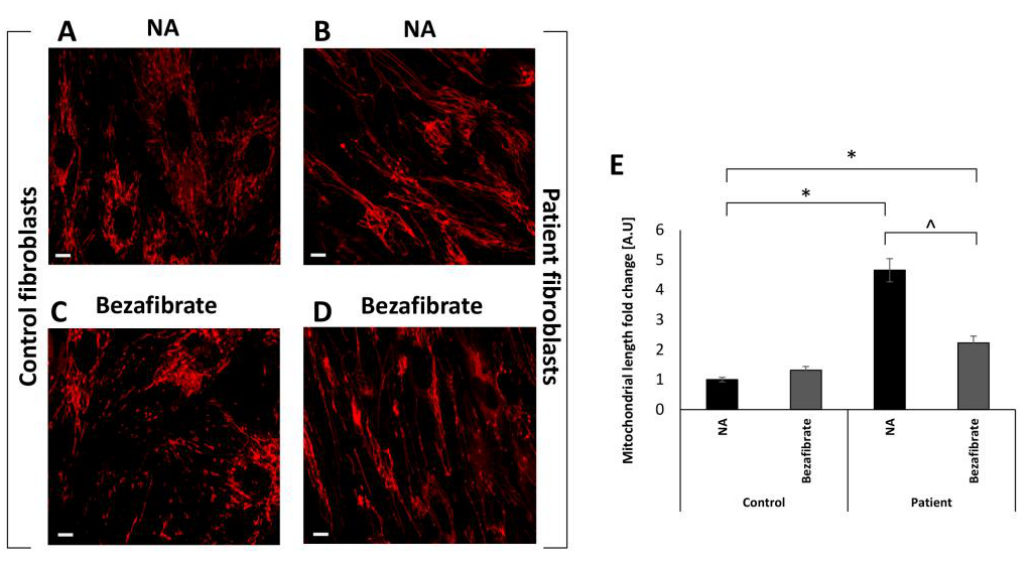
Figure 2. Mitochondrial morphology. Control ( A,C ) and the patient’s fibroblasts ( B,D ) were seeded in 35 mm glass-bottom tissue culture plates. The following day, the medium was replaced with fresh high-glucose medium without ( A,B ) additive (NA) or in the presence of bezafibrate ( C,D ) and incubated for 72 h. Mitochondrial morphology was visualized by MitoTracker Red CM-H2XRos. Relative mitochondrial length was calculated and depicted ( E ) using ImageJ software. Mean normalized to control no additive ± SEM; * p < 0.05 compared to NA control; ˆ p < 0.05 compared to same cell with no additive. Scale bar = 10 µM.